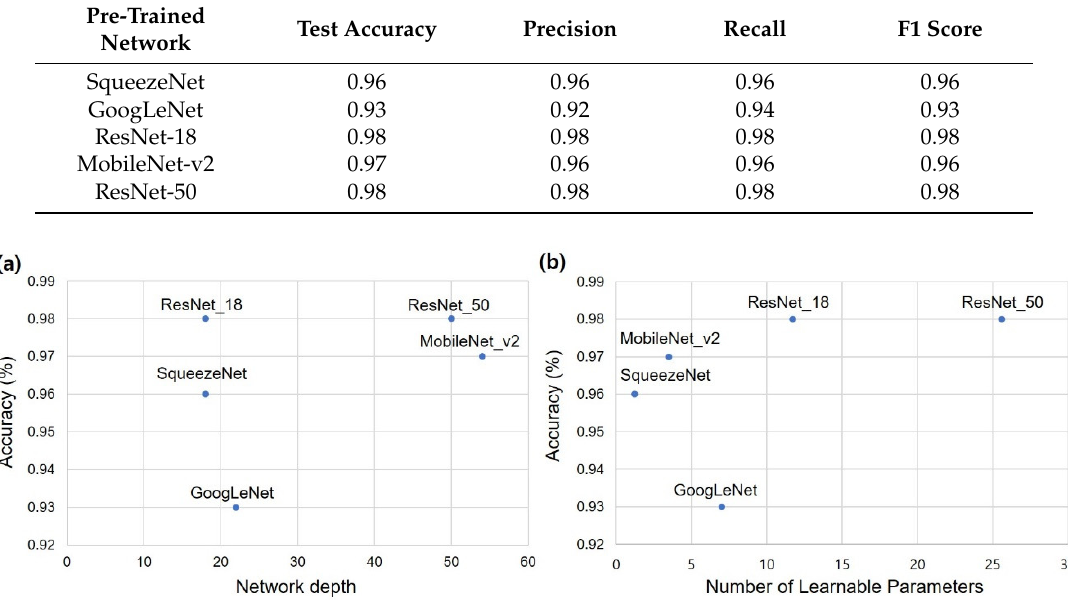
Table 3. Accuracy of implant fixture system classification according to the pre-trained networks in this research.